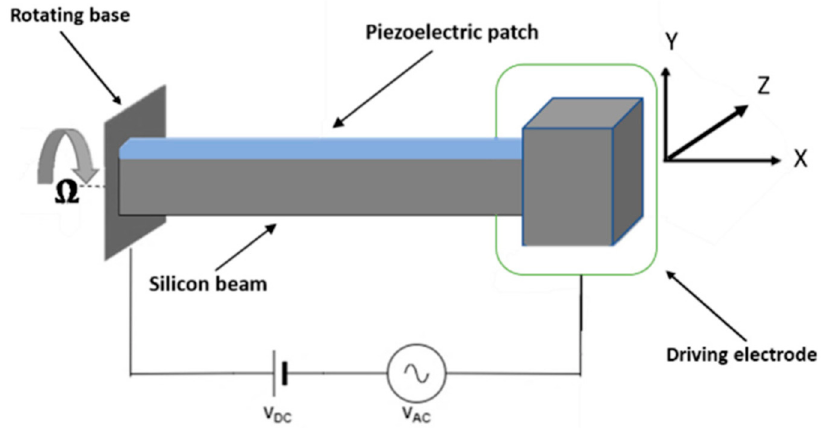
Figure 3. Schematic of the gyroscope sensor with energy harvesting capabilities [7].